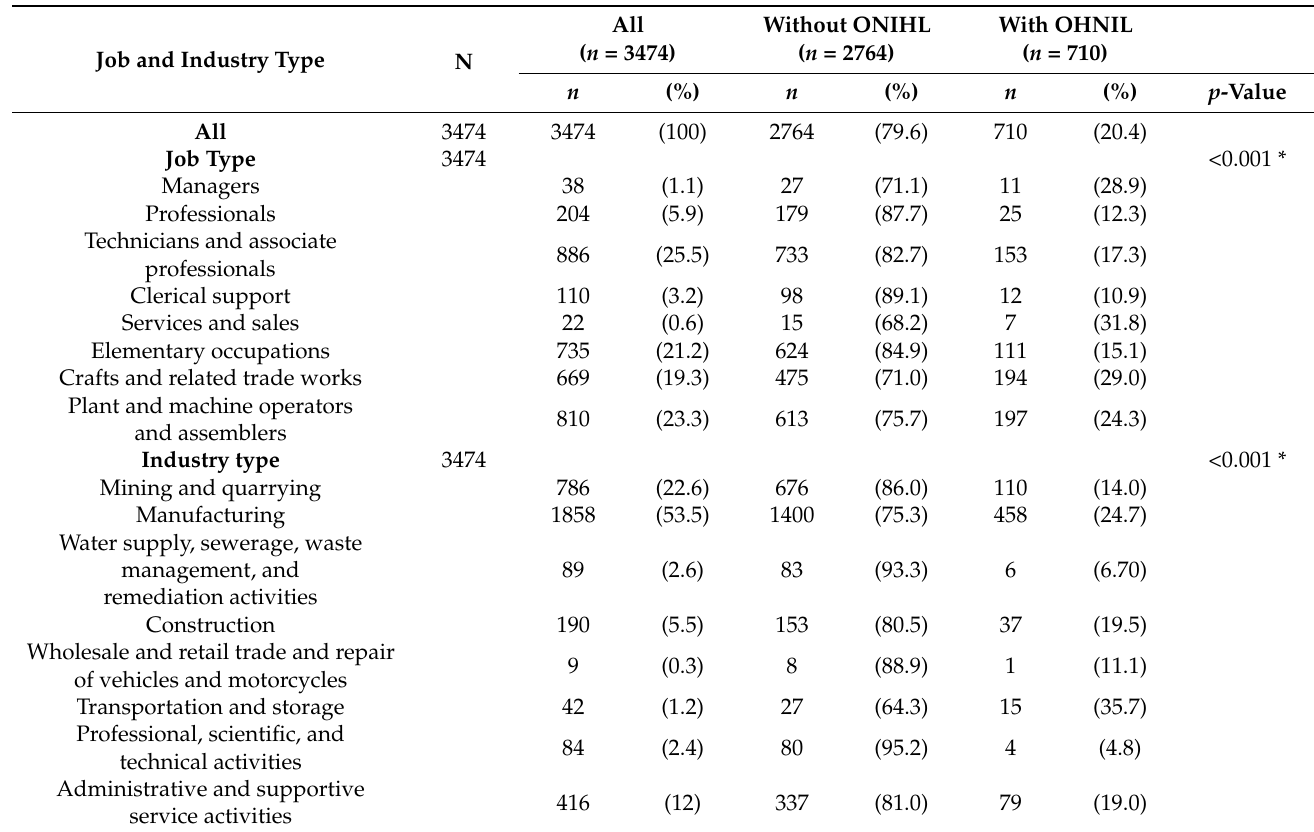
Table 2. Baseline job and industry type of industrial workers according to occupational noise-induced hearing loss